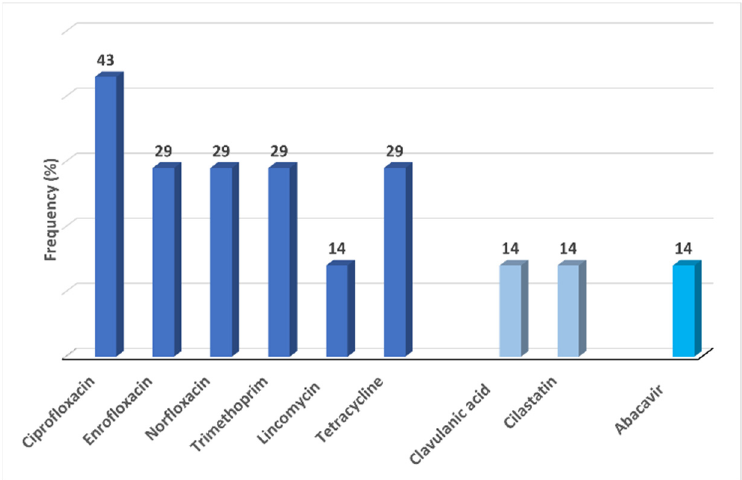
Figure 2. Frequency (%) of antibiotics/enzyme inhibitors and abacavir detected in groundwater.